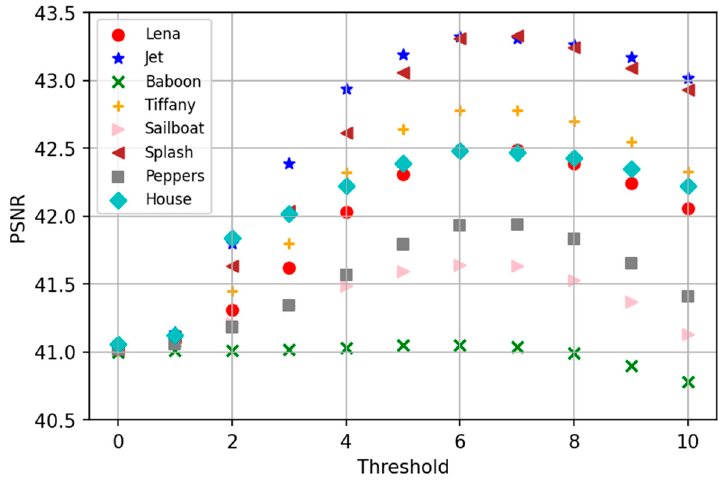
Figure 4. The plot of threshold T versus PSNR for various test images.